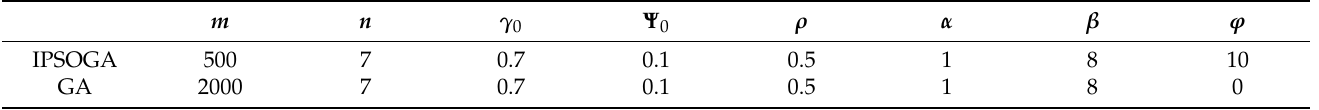
Table 3. Parameters of PSO.